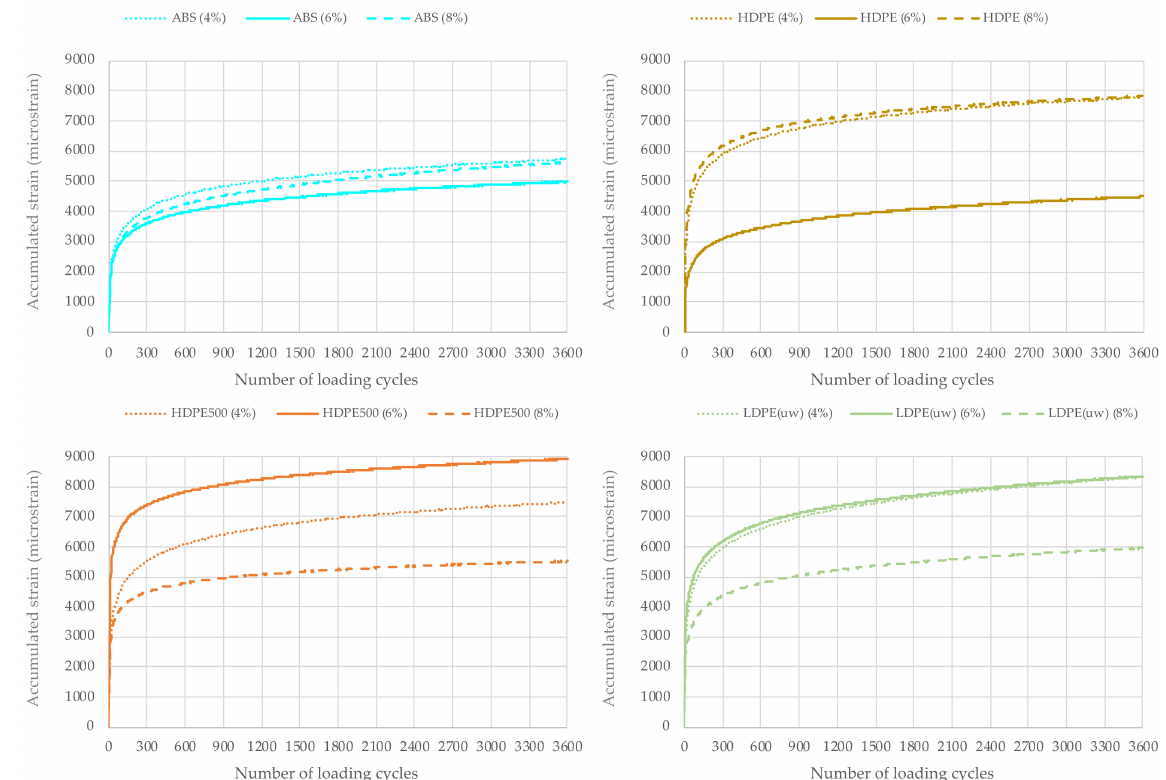
Figure 13. Influence of the plastic waste content on the accumulated permanent deformation mea- sured in cyclic compression tests at 60 ◦ C for the four types of plastic waste